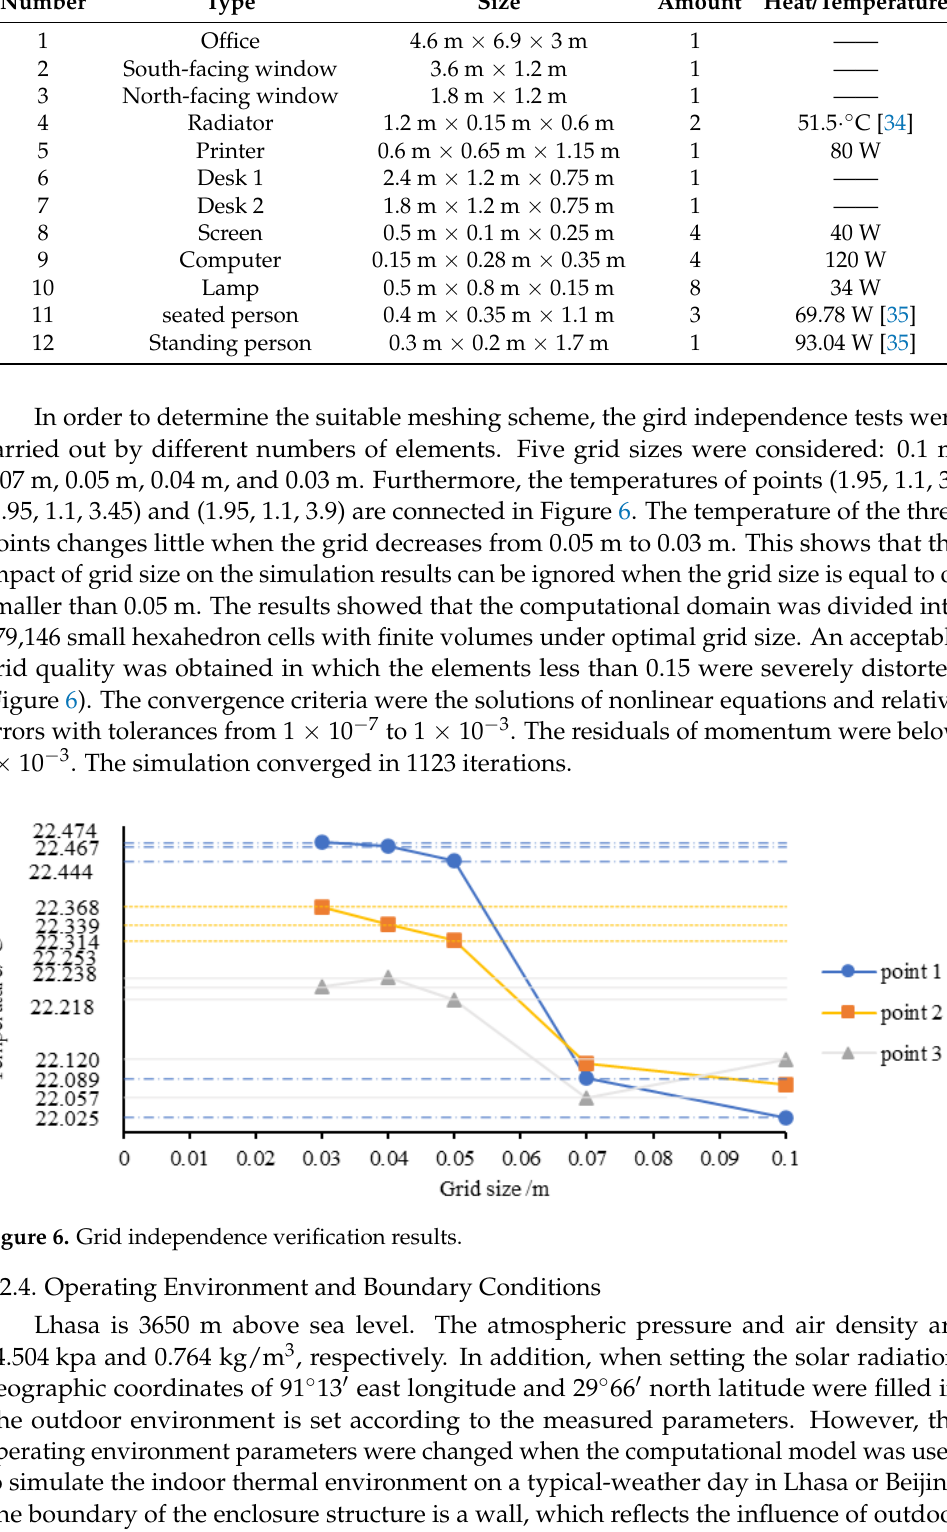
Table 3. The parameters of the computational model of the office.